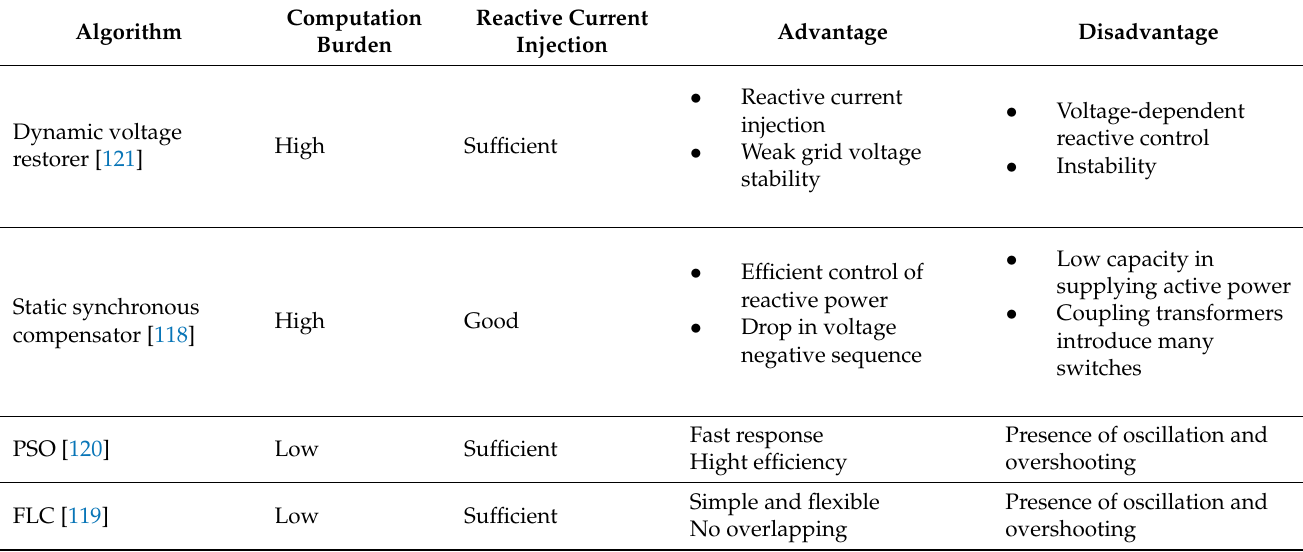
Figure 10. AI approach for low voltage ride through in grid-connected PV systems. Table 7. Comparison of low voltage ride through